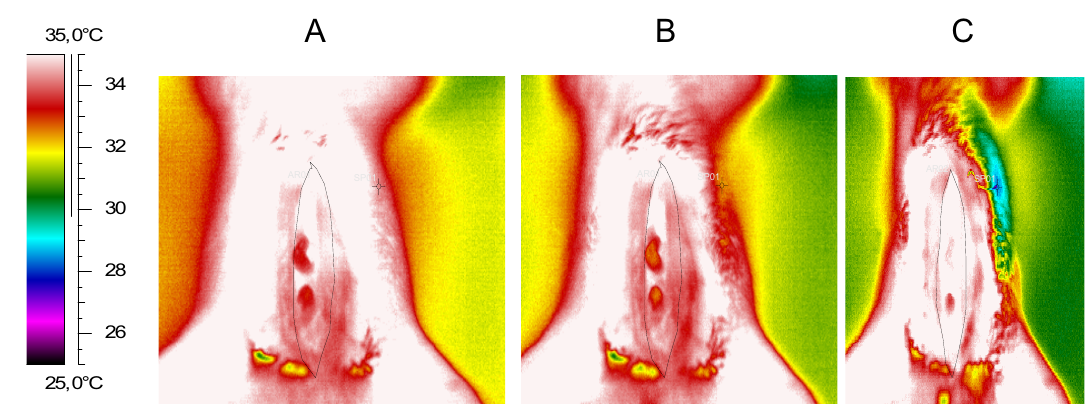
FIGURE 5 – Thermograms in group II: A – before ischemia; B – after 30 minutes of ischemia; C – after reperfusion